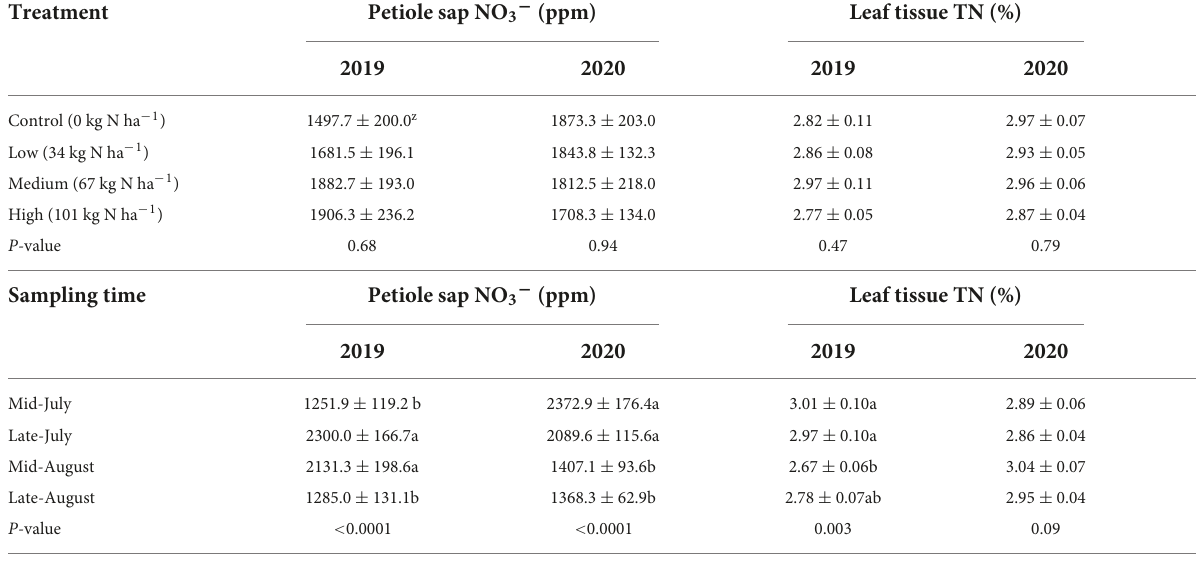
TABLE 2 “Meeker” floricane red raspberry petiole sap nitrate (NO 3 − ) and leaf tissue total nitrogen (TN) concentrations by nitrogen fertilizer rate treatments and sampling time, 2019 and 2020. Treatment